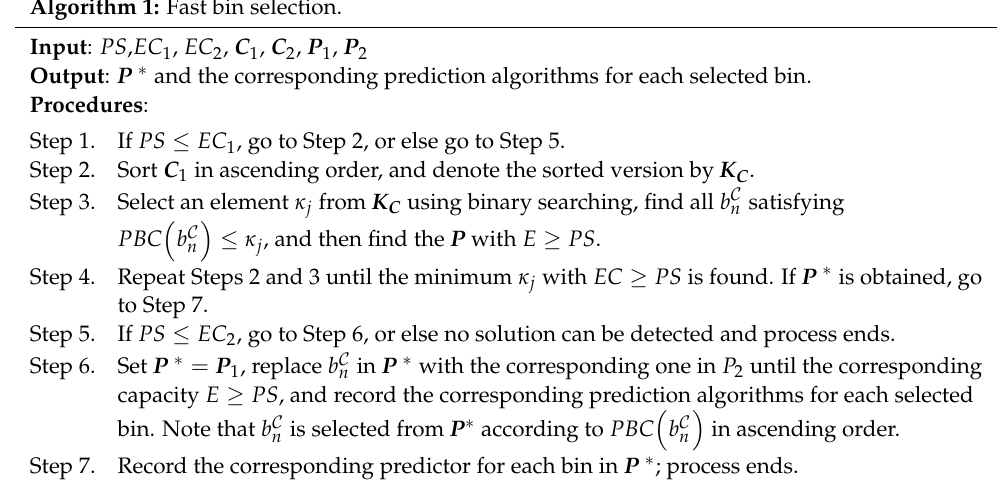
Algorithm 1: Fast bin